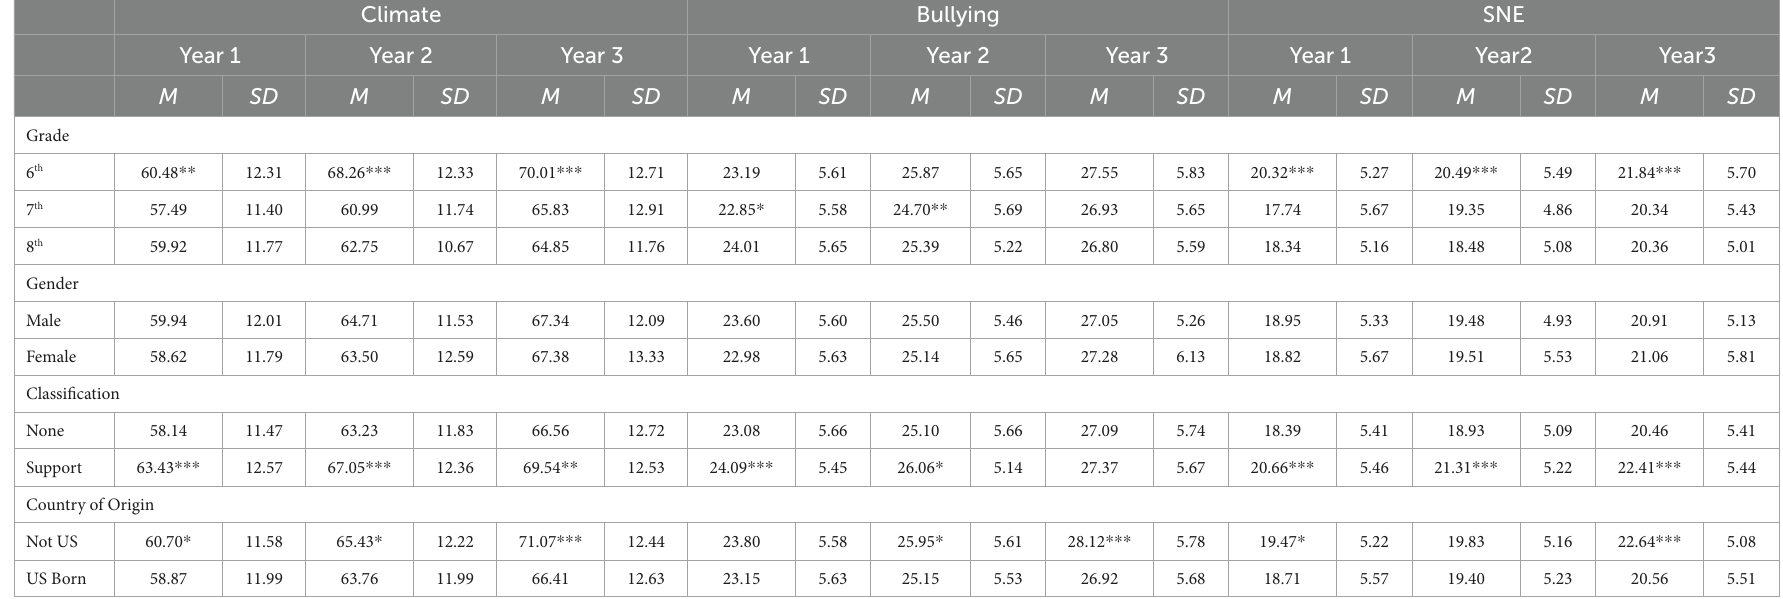
TABLE 8 Impact of demographic covariates on social emotional learning environment factors.